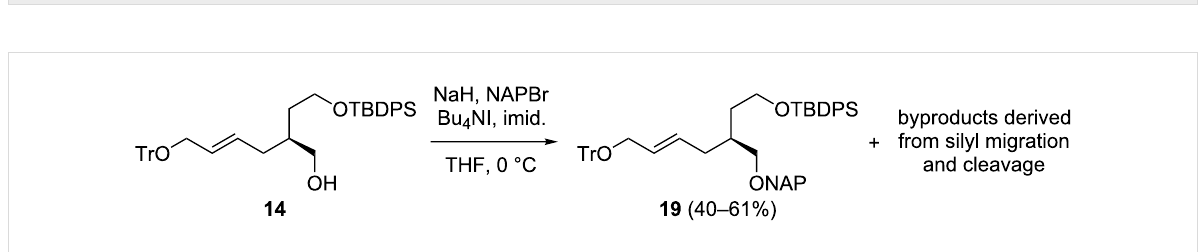
Scheme 3: Synthesis and attempted ring-opening of epoxide 17 .